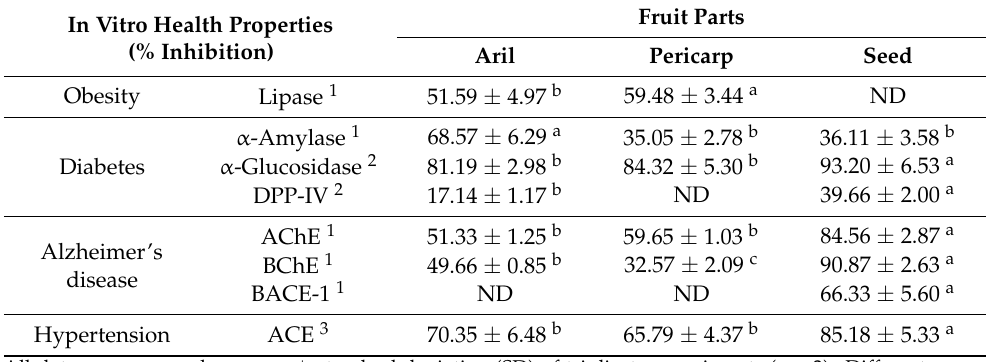
Table 6. Enzyme inhibitory activities of different fruit parts of Nephelium hypoleucum Kurz. In Vitro Health